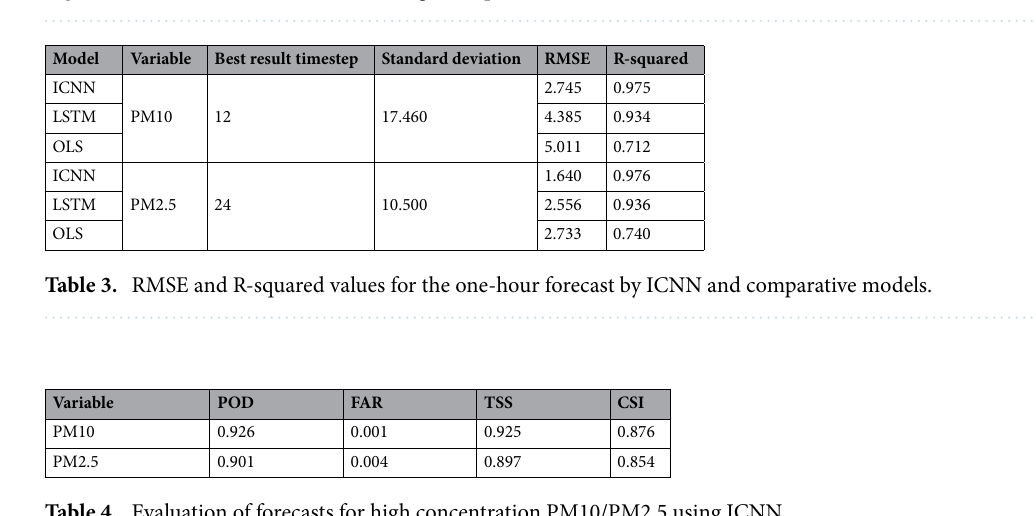
Figure 4. RMSE for short-, mid-, and long-term prediction models.